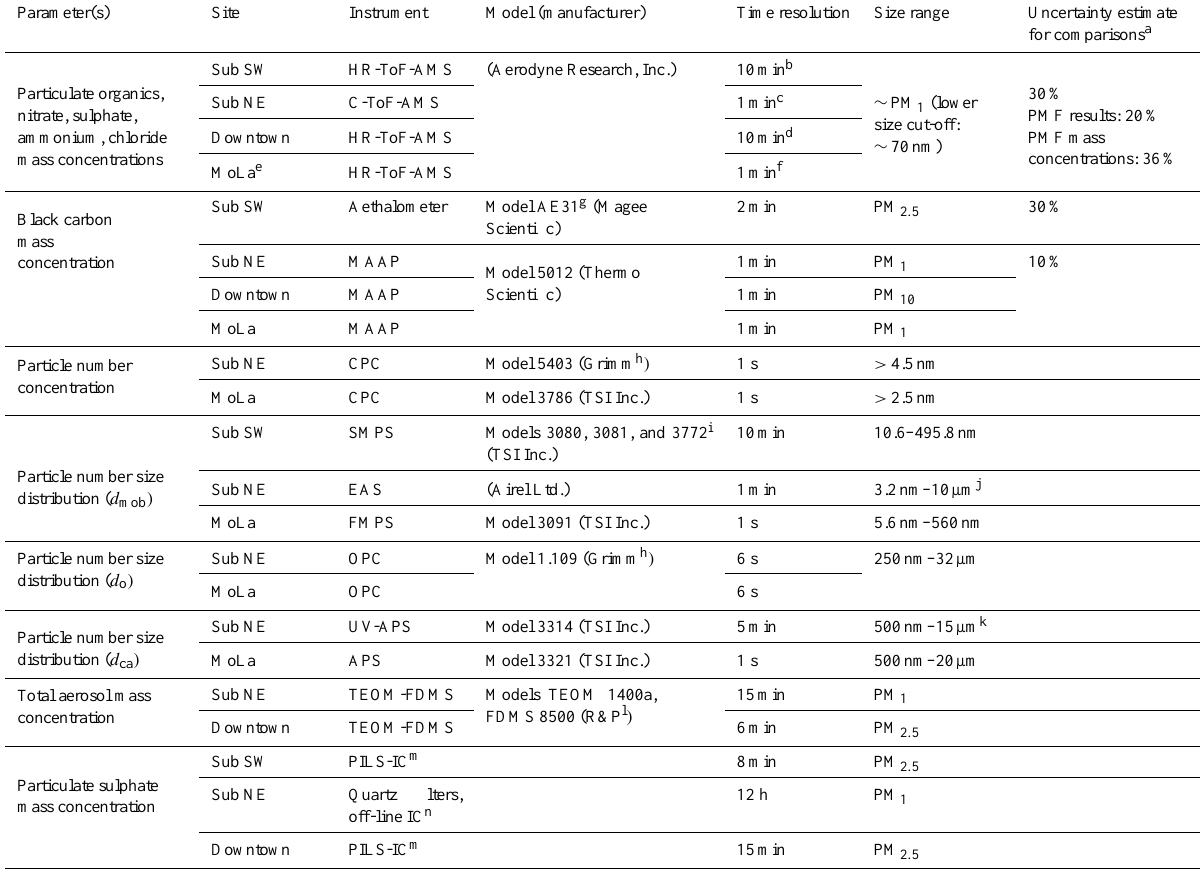
for comparisons a